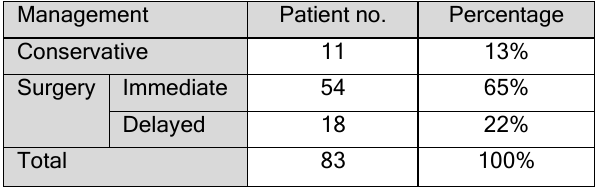
Table (5)Distribution of patient in relation to Line of Management